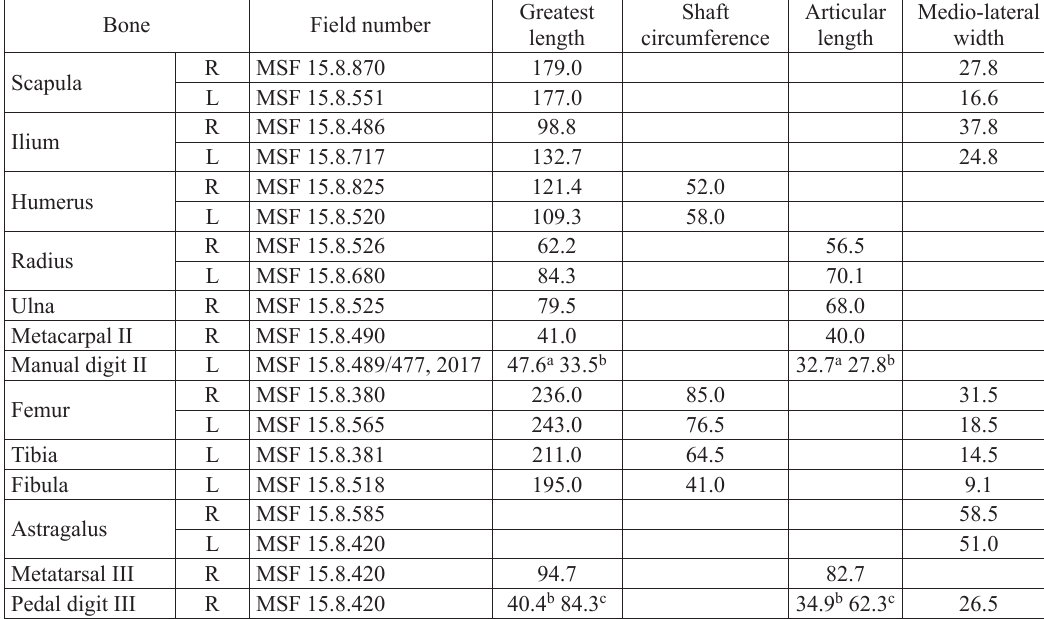
Table 2. Selected measurements (in mm) of appendicular skeleton of juvenile Plateosaurus cf. trossingensis (MSF 15.8B.). Greatest length is measured in a straight line. Articular lengths are measured between deepest depression or middle of articular surfaces. Medio-lateral widths are measured at midshaft for humerus, femur, tibia and fibula, at the thickest portion for other bones. Abbreviations: L, left; R, right. Phalanges a 2 combined non-ungual, b ungual, c 3 combined